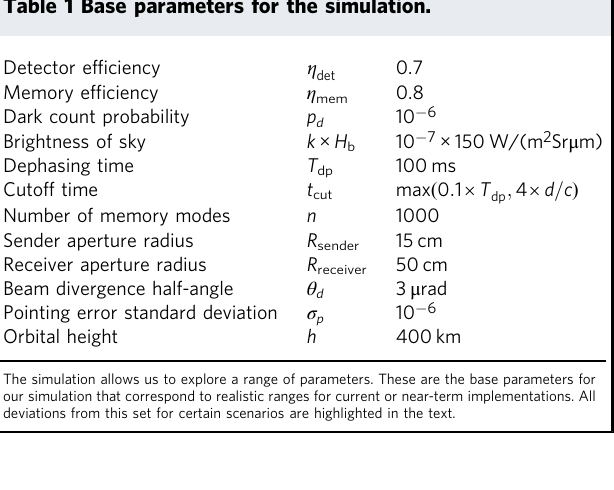
Table 1 Base parameters for the simulation.